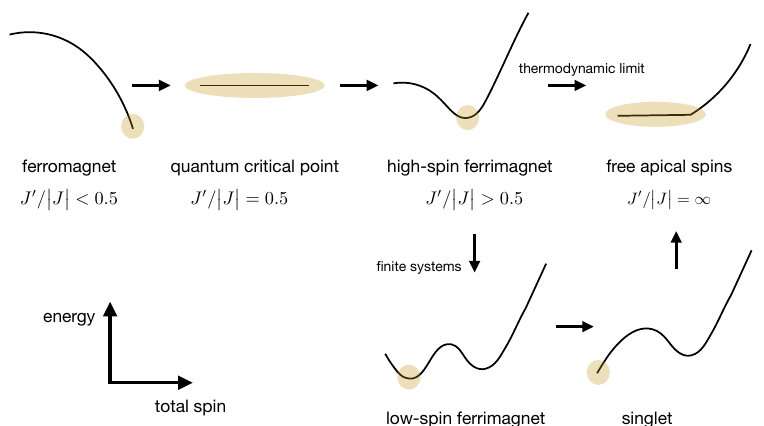
) . The parameter tot